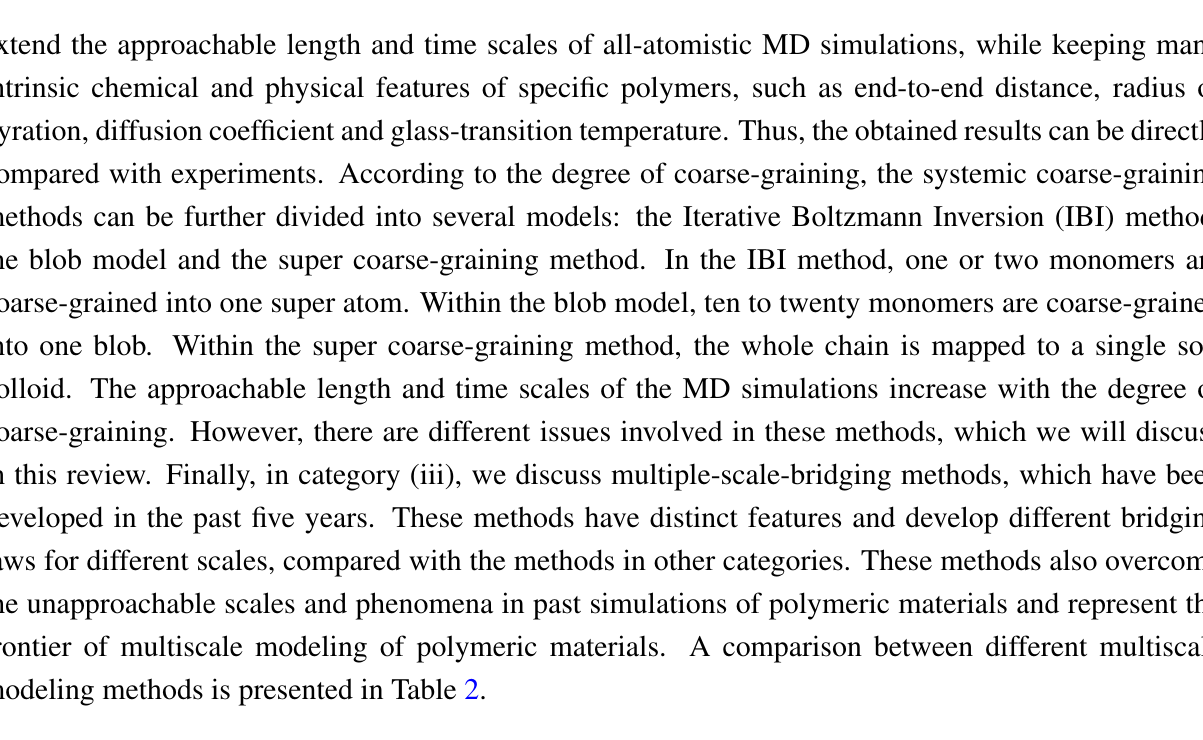
Table 1. Summary of the methods discussed in this